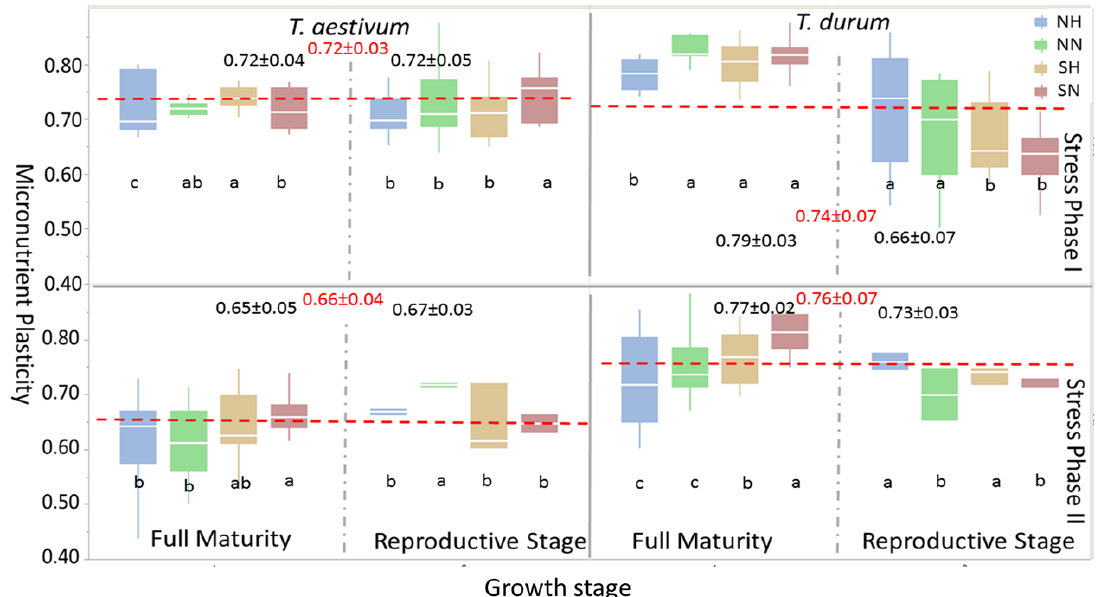
Figure 5. Box-plots and mean separation (means followed by the same letter within each growth stage do not differ significantly using Tukey’s HSD; p < 0.05) of micronutrients index phenotypic plasticity estimates for two wheat genotypes representing T. durum and T. aestivum subjected to three levels of abiotic stresses (NH, normal length of growing season, SN, short growing season and normal population density, and SH, short growing season and high population density) and compared to a control (NN, normal length of growing season and normal population density) during reproductive and full maturity growth stages.